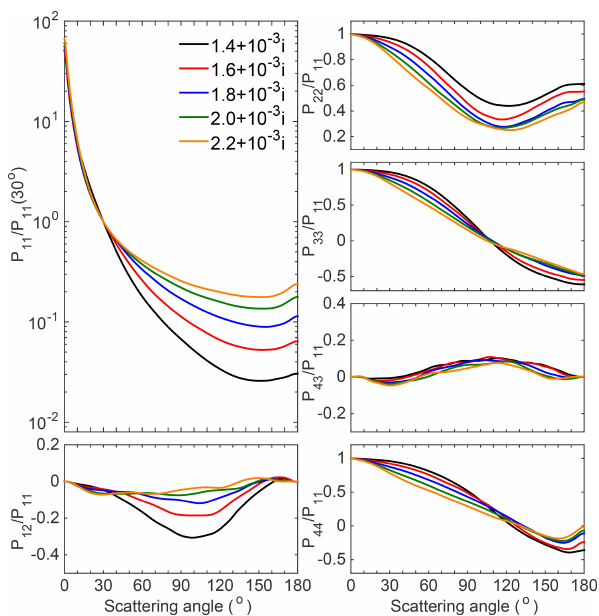
Figure 3. Simulated scattering matrix elements for Koch-fractal particles with different refractive indices. Here, the imaginary part is fixed at 0.001 i , and the real part is changed from 1.4 to 2.2 with a step of 0.2. The particles are assumed to have the size distribution of feldspar, and the optical properties are simulated by considering an incident wavelength of 633nm.